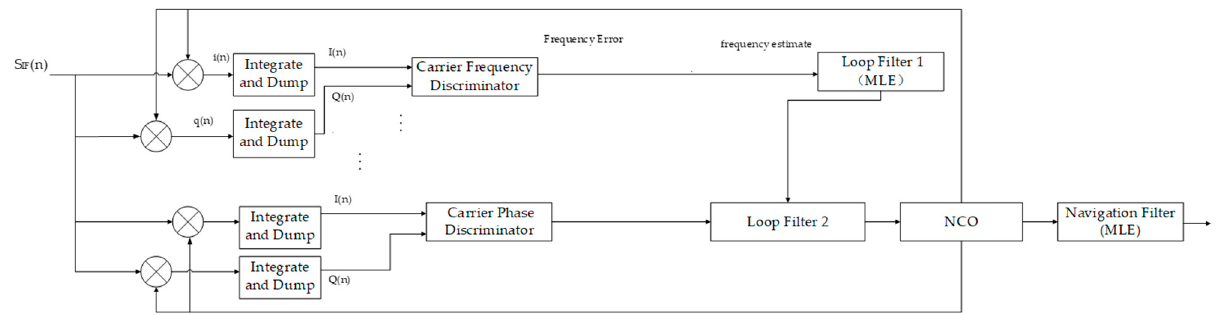
Figure 1. Block diagram of the VFLL-assisted PLL structure.